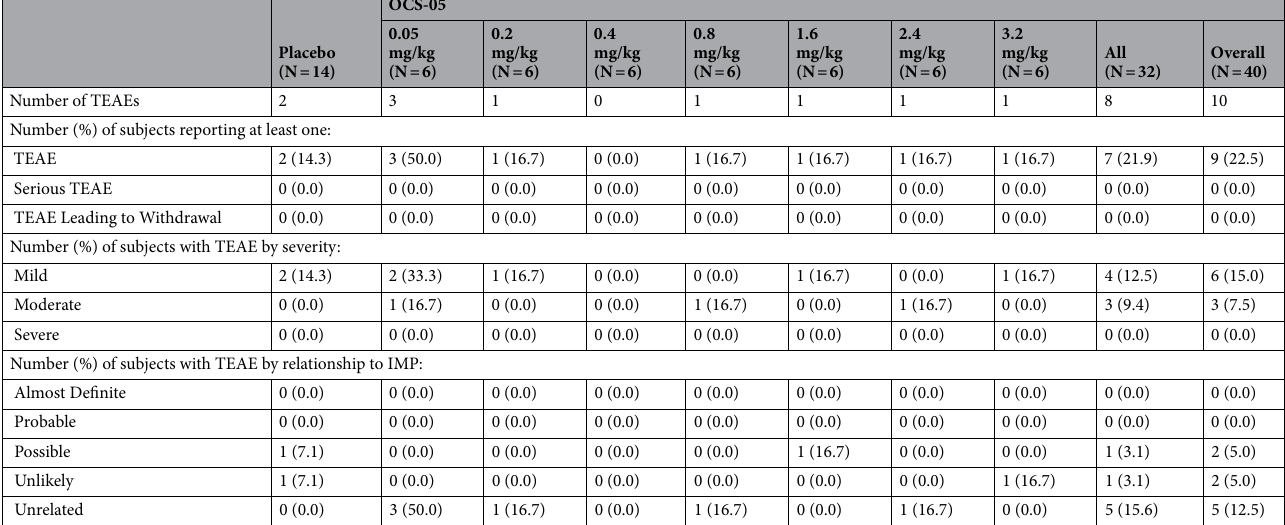
Table 2. Overall summary of TEAEs – SAD part.